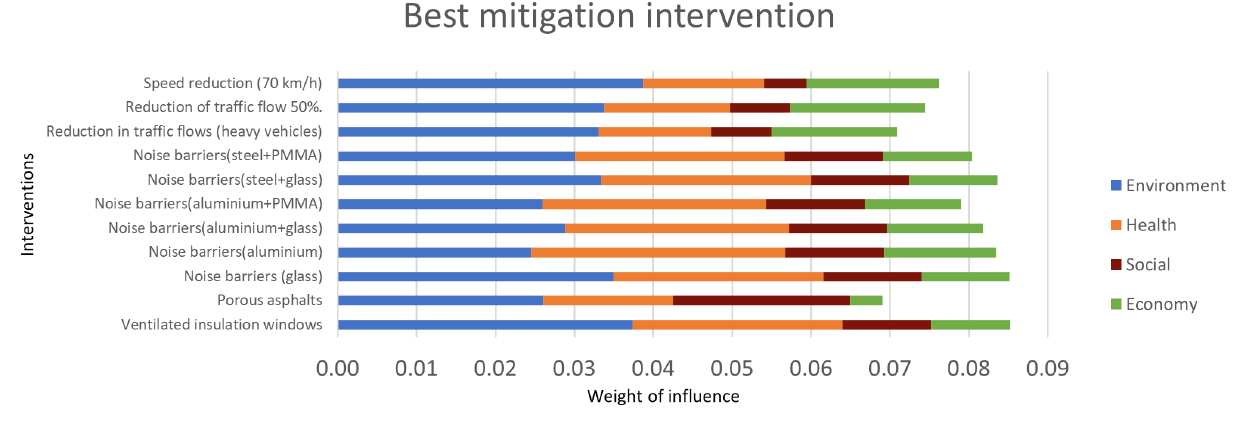
Figure 12: Analysis results for the daytime scenario